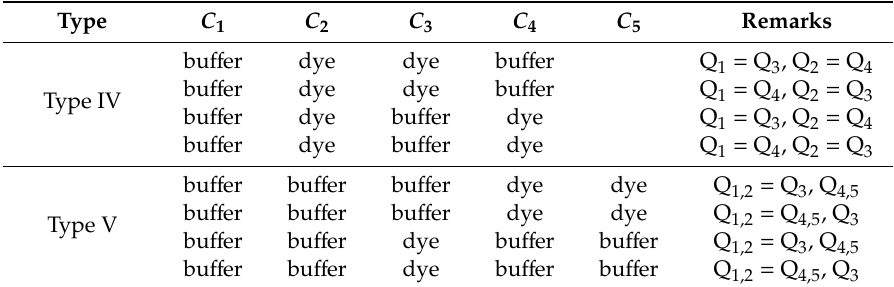
Table 1. Four typical statuses of type IV and type V concentration gradient maker